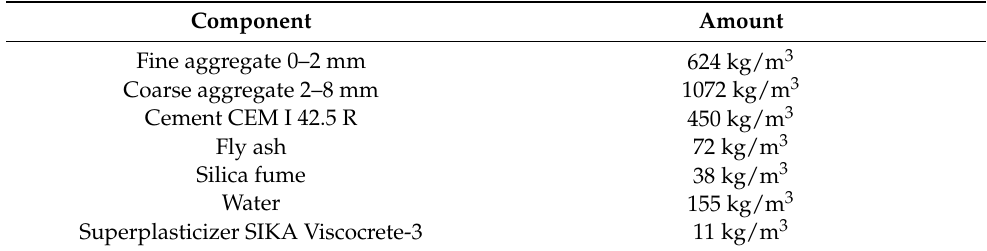
Table 1. The design of the mix used in the study.